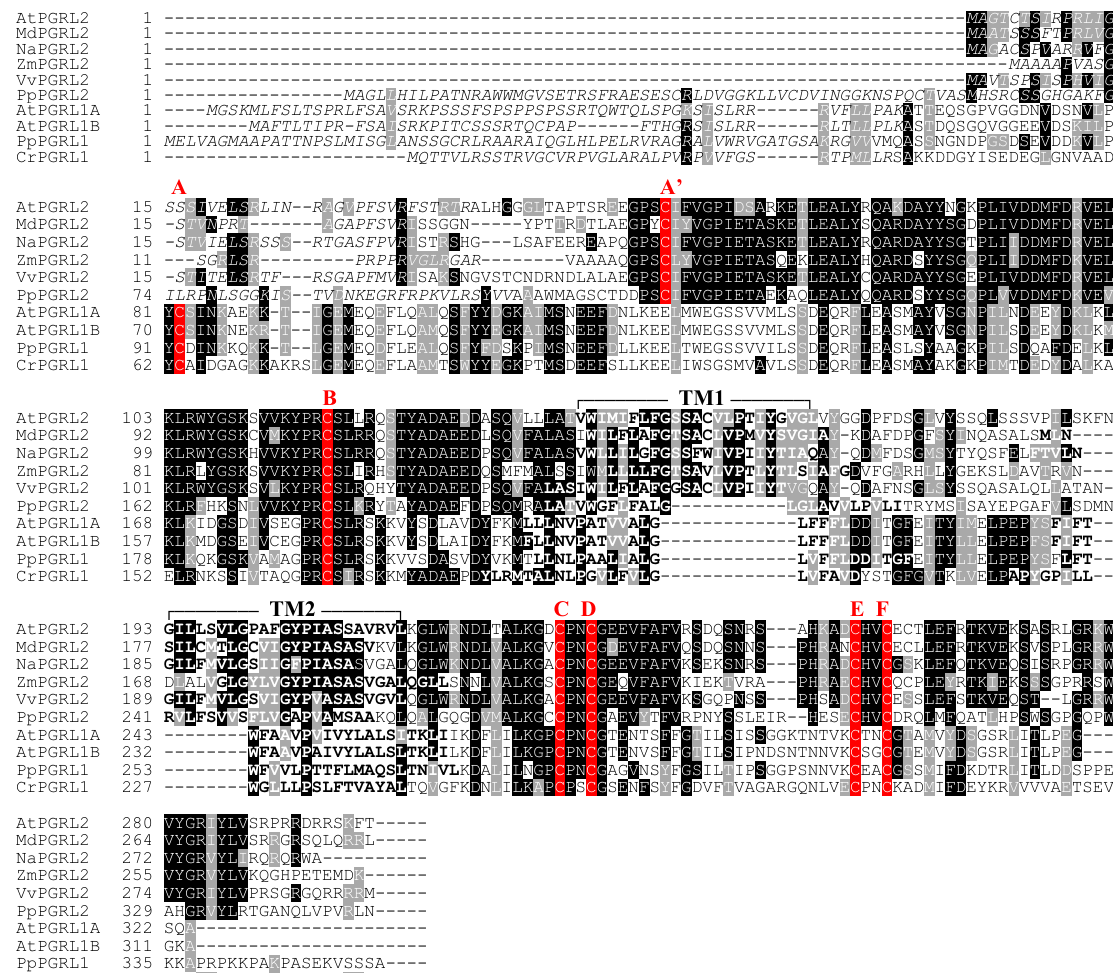
Fig. 1 PGRL2 and PGRL1 share characteristic features. Multiple sequence alignment of PGRL1 and PGRL2 family members. Conserved cysteines are highlighted in alphabetical order. Aligned cysteines identi fi ed only in PGRL2 are depicted as A ’ . Predicted transit peptide sequences and transmembrane domains (see “ Methods ” ) are shown in italic and bold letters, respectively. The two AtPGRL2 transmembrane domains are indicated by the overhead brackets marked “ TM1 ” and “ TM2 ” . Instances of sequence identity/similarity in at least 40% of the sequences are highlighted by black/gray shading. The accession numbers of the sequences are listed in Supplementary Table